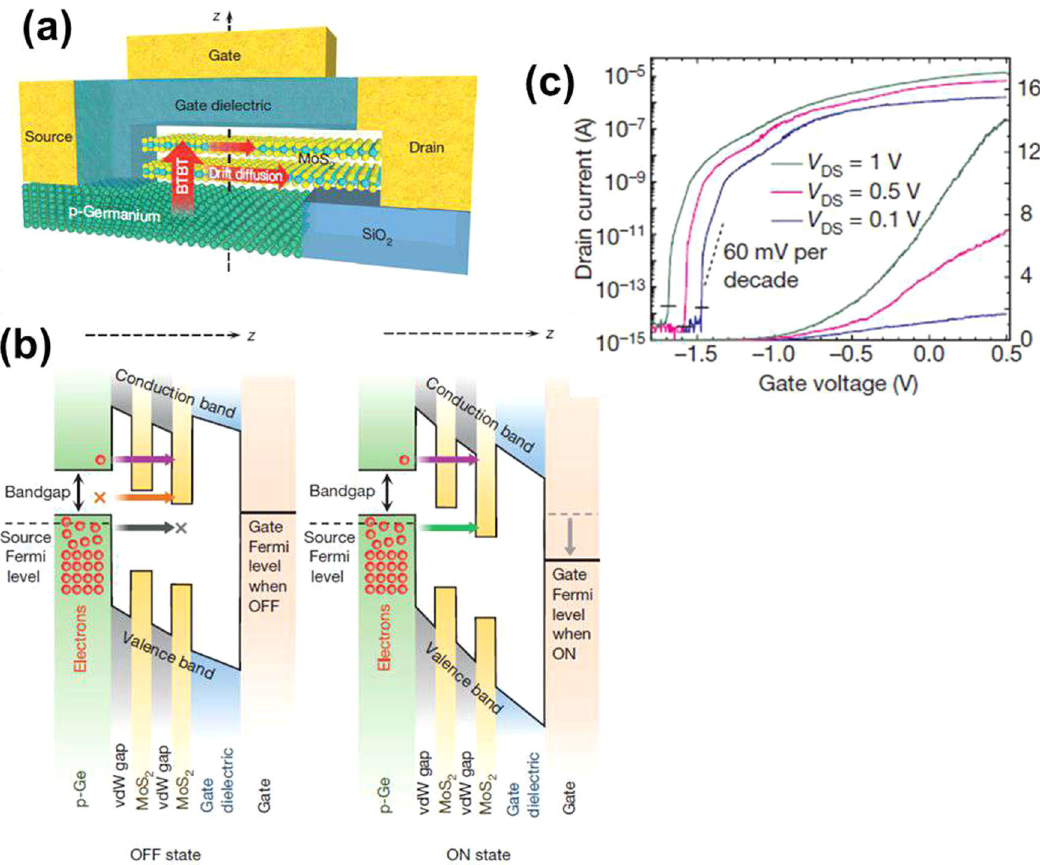
Fig. 25 Experimental Report on 3D/2D MoS 2 -TFET. a Device schematics, b on-state/off-state band alignments at the tunneling junction c transfer characteristics of Ge-source/2L-MoS 2 -channel, adapted with permission from 135 . Copyright (2015)